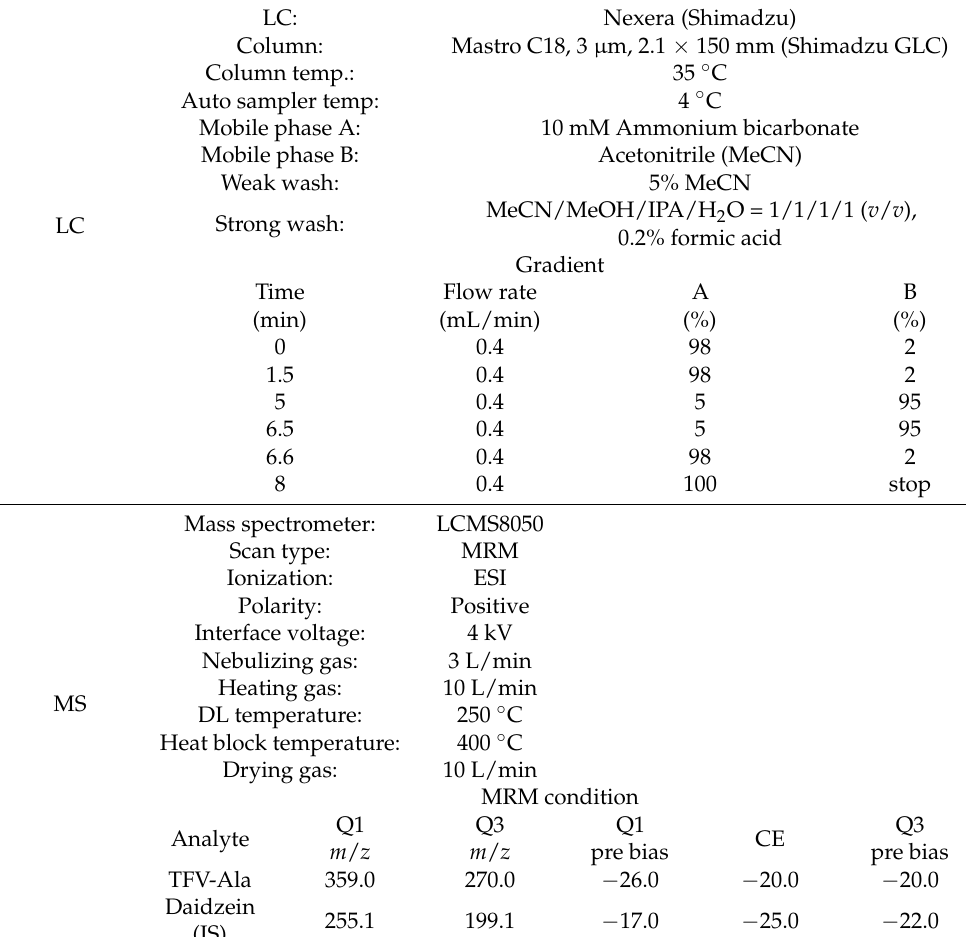
Table 2. LC/MS/MS condition for the analysis of